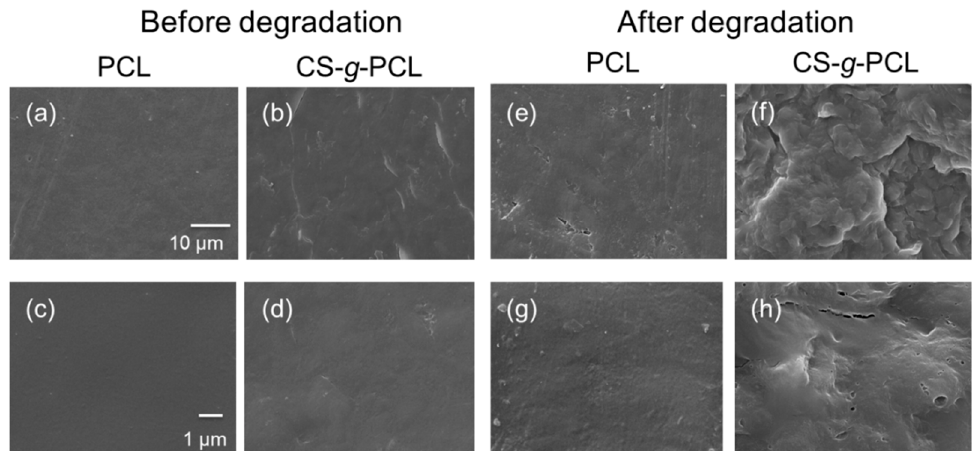
Figure 6. SEM images of the PCL and CS-g-PCL disc samples as prepared ( a , c and b , d , respectively) and after 21 days of degradation in α -MEM ( e , g and f , h , respectively). Top panel: 2000-fold magnification, scale bar represents 10 µ m; bottom panel: 10,000-fold magnification, scale bar represents 1 µ m.